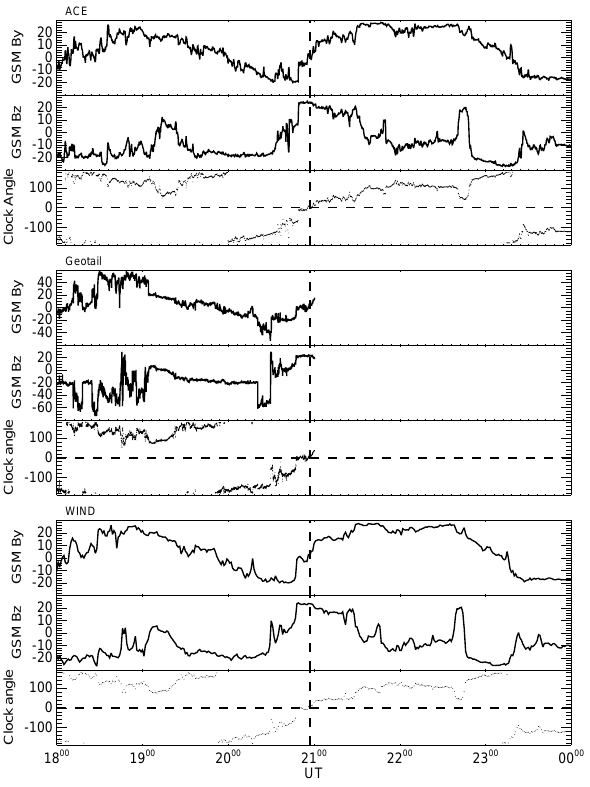
Fig. 2. GSM B Y and B Z interplanetary magnetic field components along with the corresponding clock angle, measured by ACE and WIND in the solar wind and Geotail in the upstream solar wind and occasionally within the magnetosheath, 18:00–24:00 UT on 21 October 2001. Vertical lines mark the average time that the clock angle passed through zero–20:55 UT.